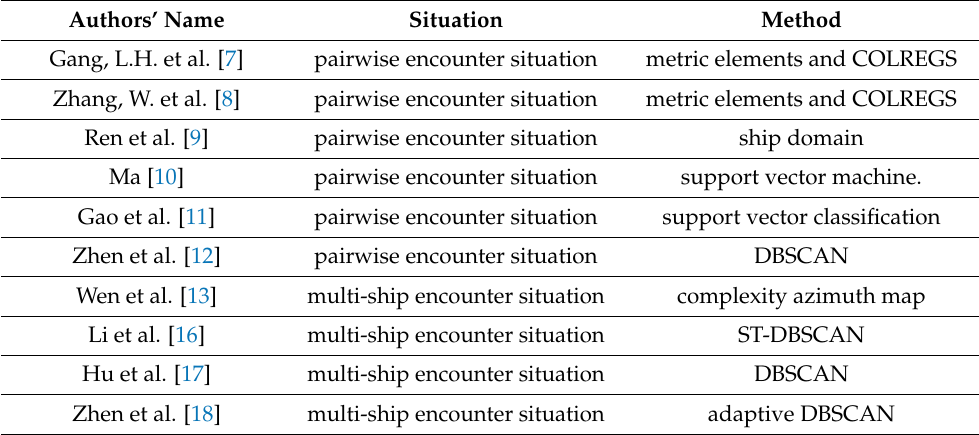
Table 1. Summary of situation identification-related works.